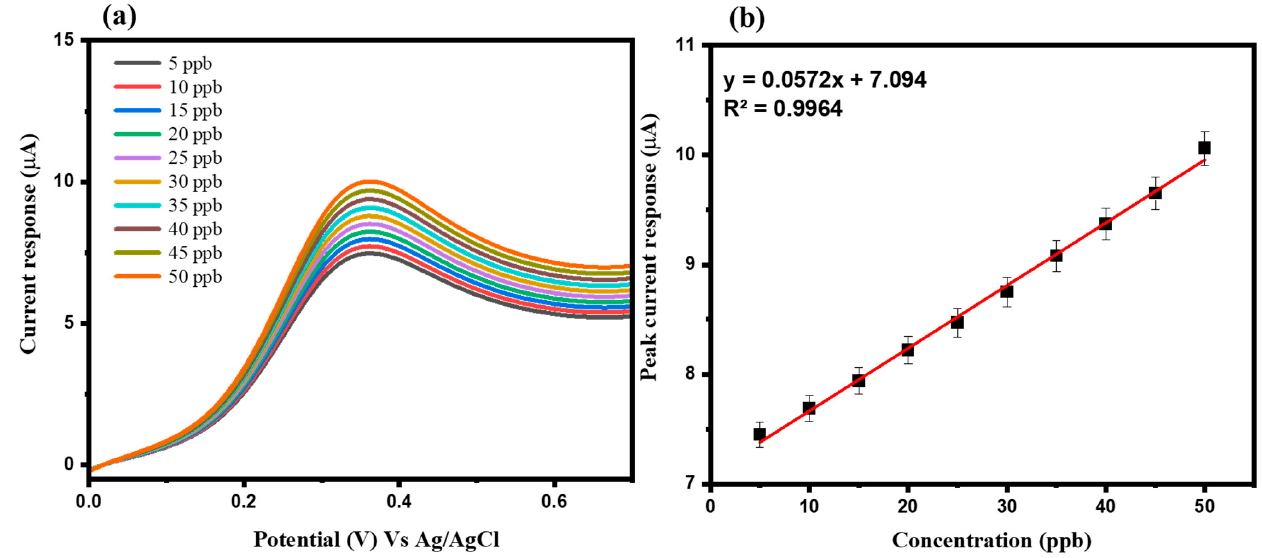
Figure 10. ( a ) LSV response and ( b ) calibration plot of the NiO-GE with respect to concentration of As 3+ (0.1 M PBS of pH = 6) at scan rate = 50 mVs − 1 .